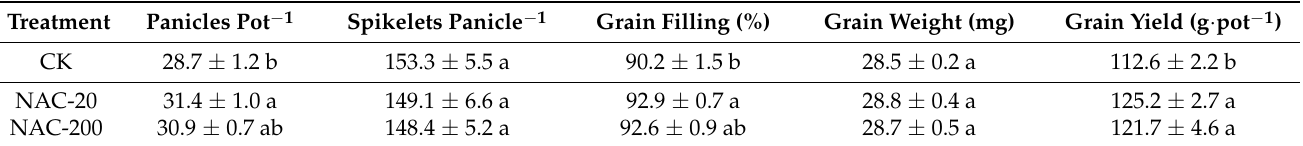
Table 1. Effects of different concentrations of NAC on yield and yield components. Figure 1. Effects of different concentrations of NAC on seedling growth at the 2 and 7 days after transplanting. CK, 0 µ m; NAC-20, 20 µ m; NAC-200, 200 µ m.